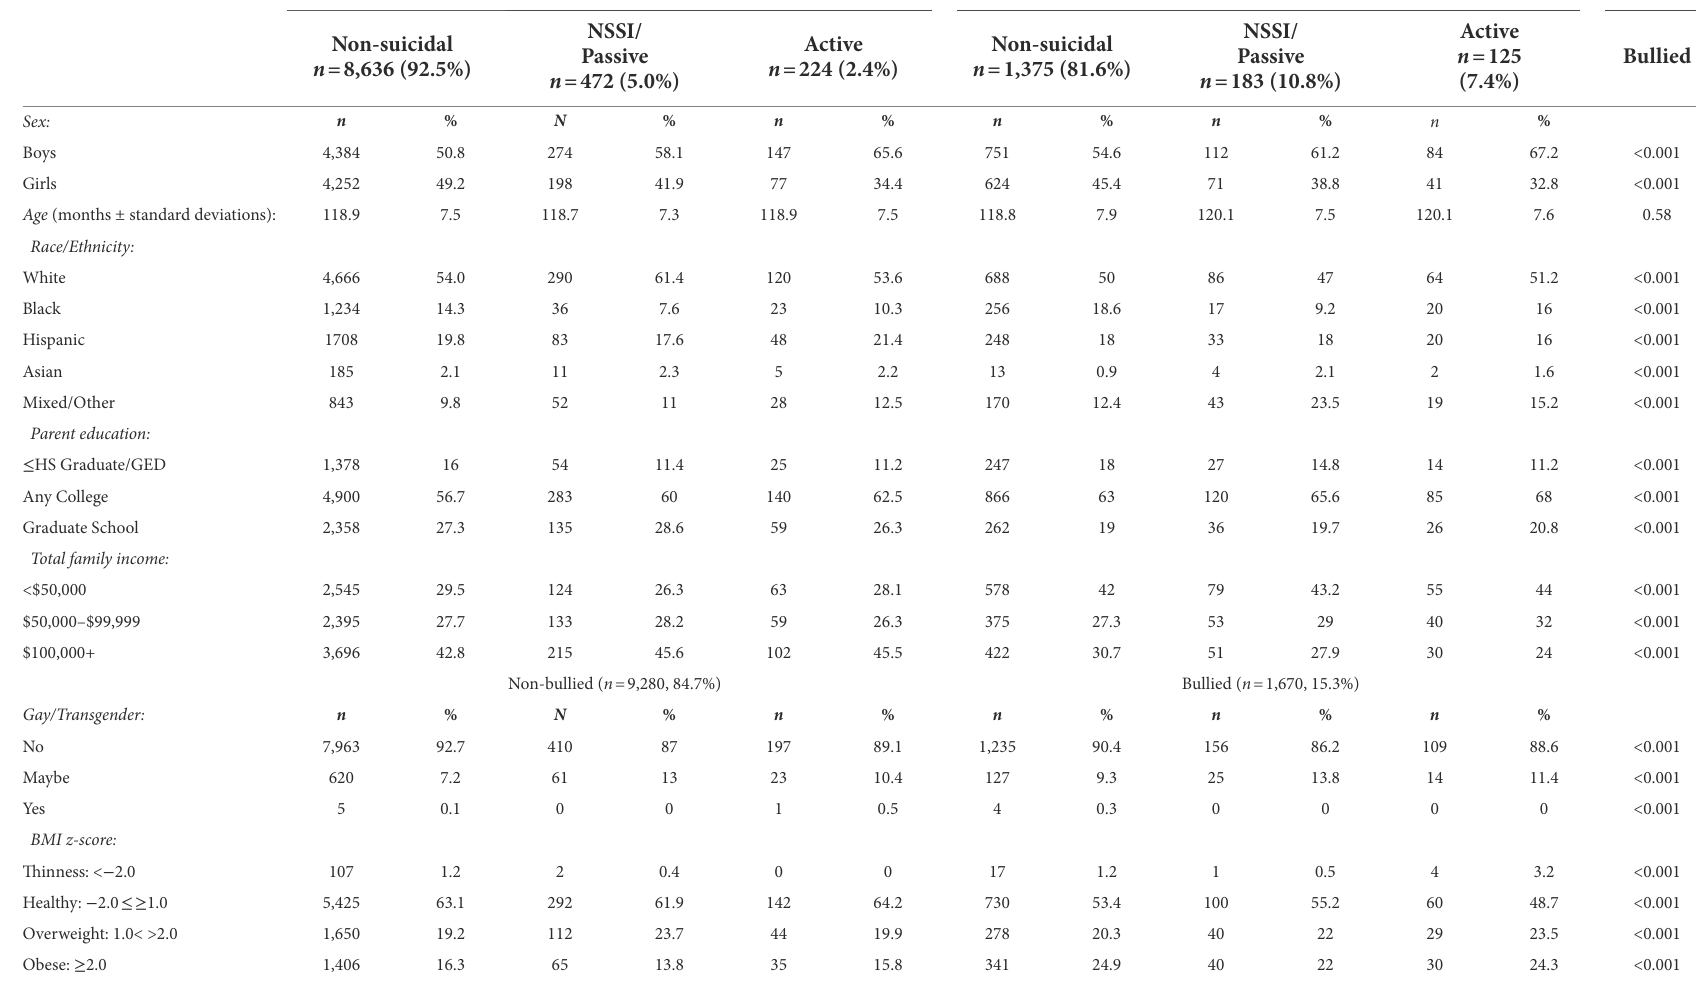
TABLE 2 An overview of sample characteristics from the ABCD Study. Non-bullied ( n = 9,332, 84.7%) Bullied ( n = 1,683,